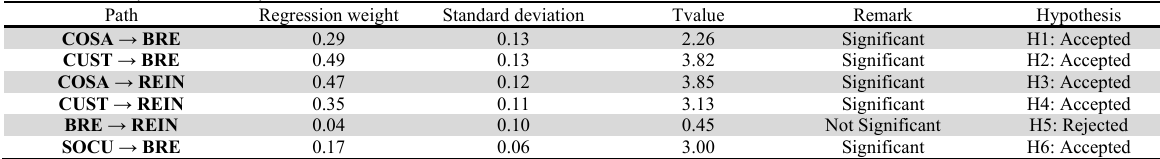
Fig. 3 . Path diagram of structural model with interaction (standardized solution) Correlation between variables ˂ 0.90. Based on the path diagram, it can be seen that there is no cross-loading indicator. These parameters indicate structural model with interactions is fit (Waluyo, 2016). The direct effect coefficient, standard deviation, and significance of the exogenous latent variable on the endogenous latent variable of the two models above related to the hypothesis can be seen in Table 1. Direct Effect